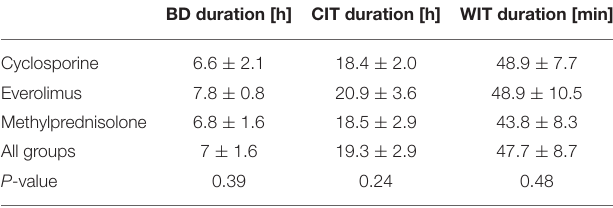
TABLE 2 | Operative times.